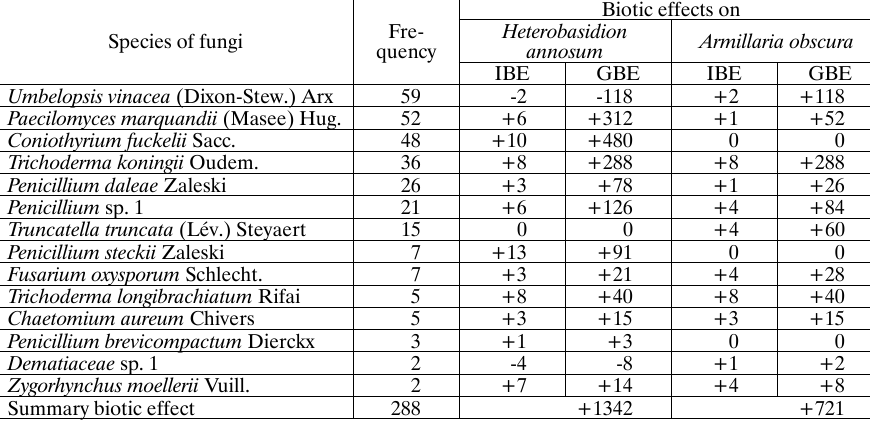
Biotic effect of rhizosphere fungi communities from healthy 2-year-old Scots pine transplants on the growth of Heterobasidion annosum and Armillaria obscura